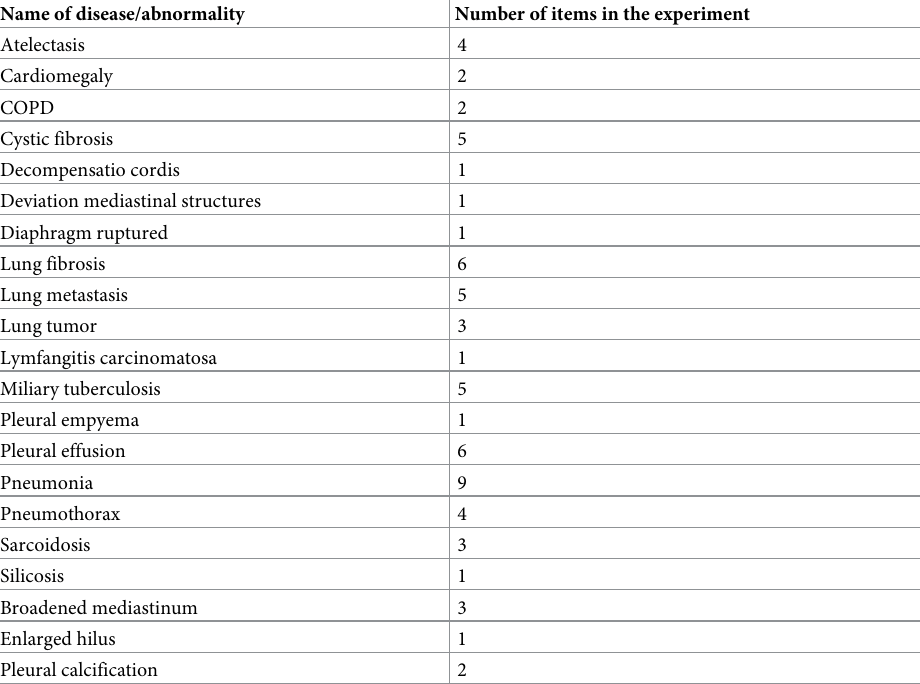
Table 1. List of different abnormalities presented. Name of